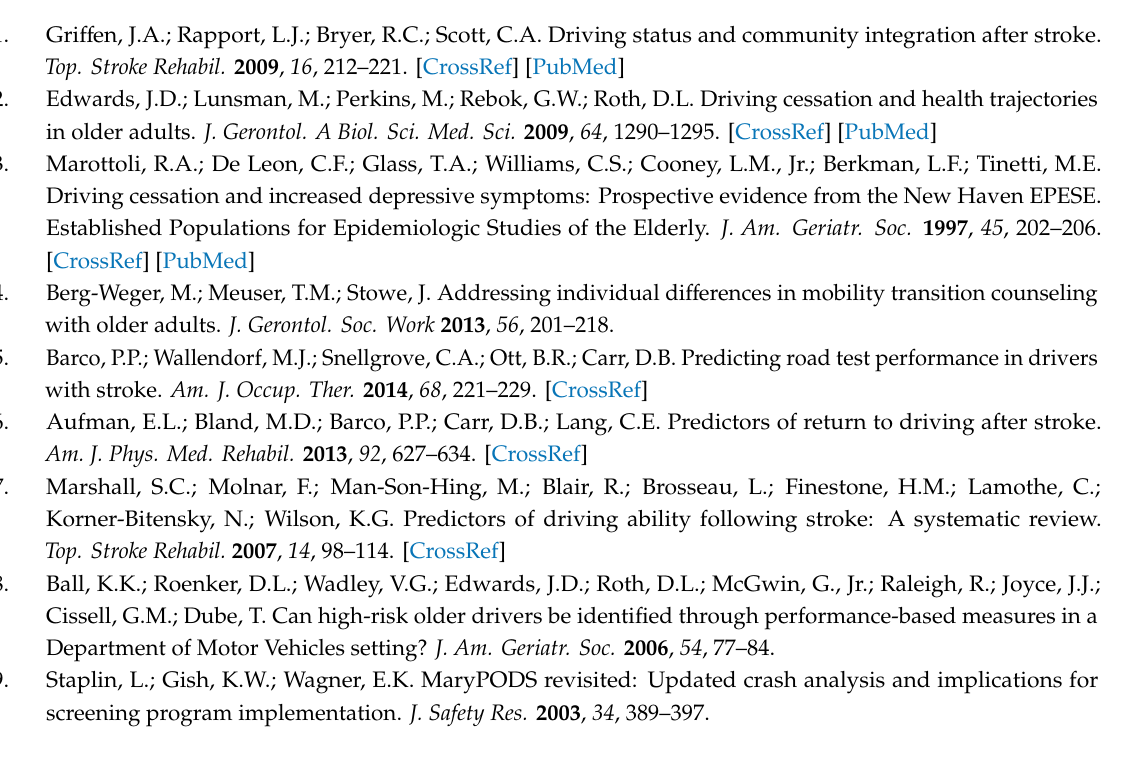
Table S1: Components, and their prices, used in consumer—grade racing simulator setup, Table S2: Comparison of by stroke to operate driving pedal, using chi-squared test or independent samples t -test, Table S3: Complete Spearman correlations of clinical psychometric and motor testing to research and racing simulator outcomes, Table S4: Complete Spearman correlations of racing simulator to research simulator outcomes, Table S5: Research simulator variables in the binary logistic regression Model 1b (with outliers replaced), Table S6: Racing simulator variables in the binary logistic regression (outliers replaced) Model